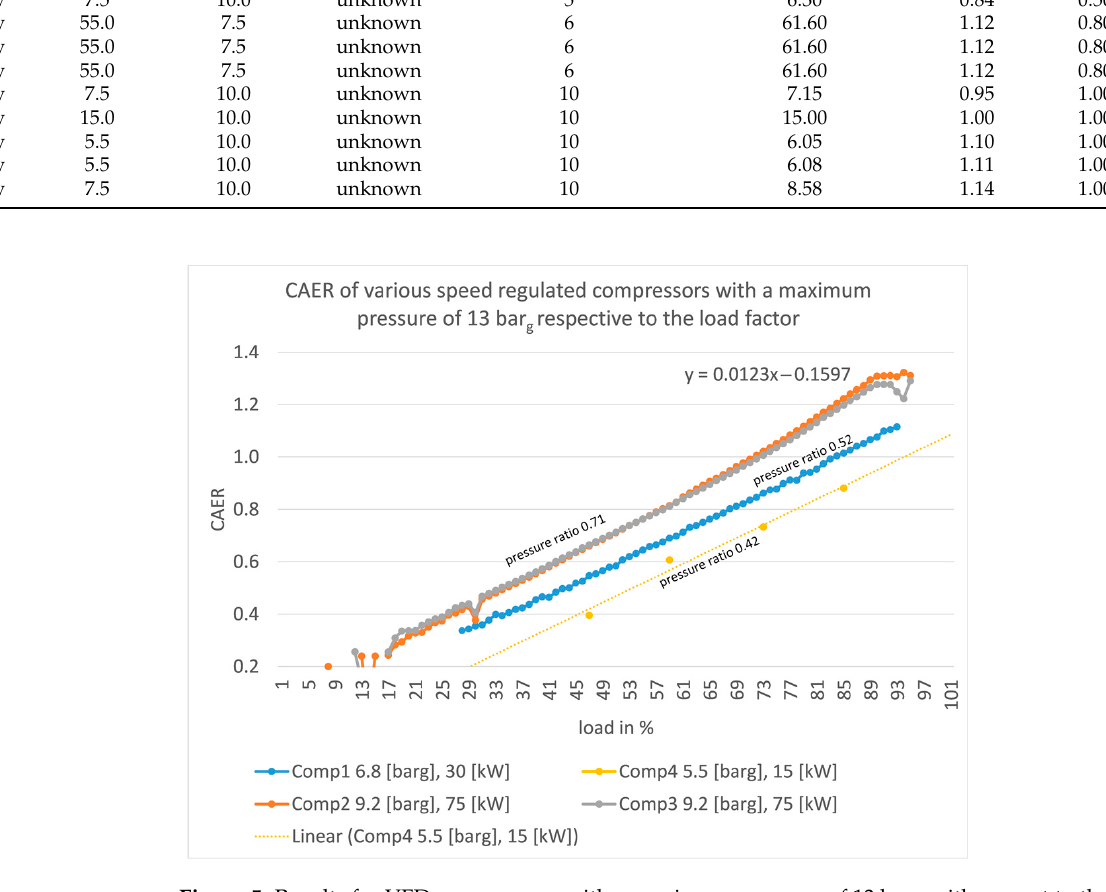
Figure 5. Results for VFD compressors with a maximum pressure of 13 bar g with respect to the load factor (source: own representation).